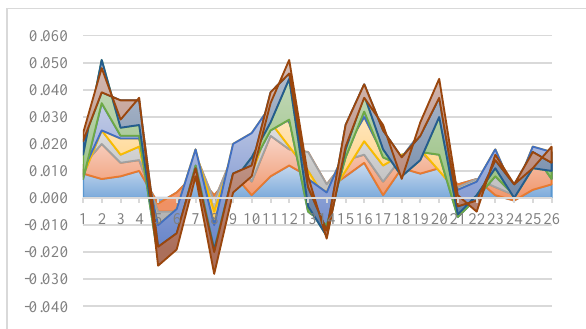
Figure 24 . Column displacements in meters.